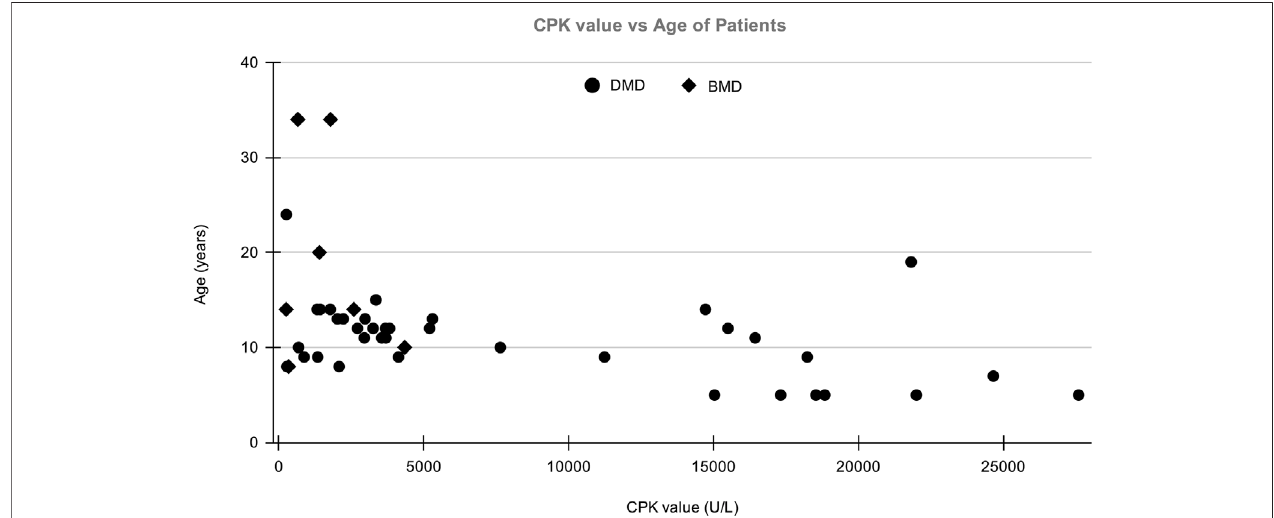
FIGURE1| Thedistributionofpatient ’ sAgevsCPKvalueinwhich X -axisshowsCPKvalue(U/L)ofpatientsand Y -axisshowstheageofDMD/BMDpatientsinour study.